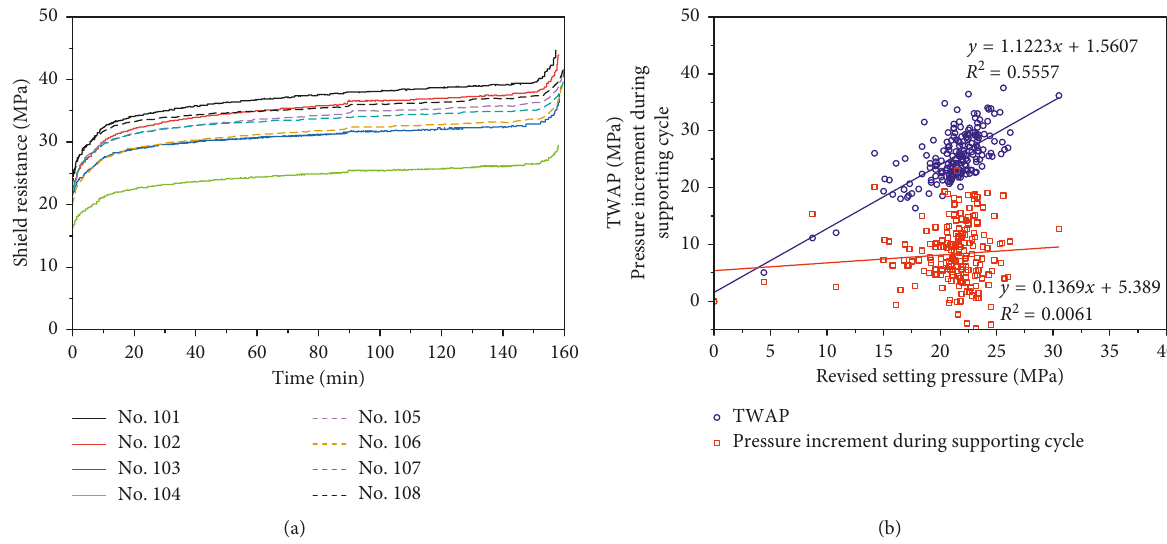
Figure 9: Effect of setting pressure when there is no yielding. (a) Temporal evolution of shield resistance of neighboring shields with different setting pressures. (b) TWAP and pressure increment versus revised setting pressure.